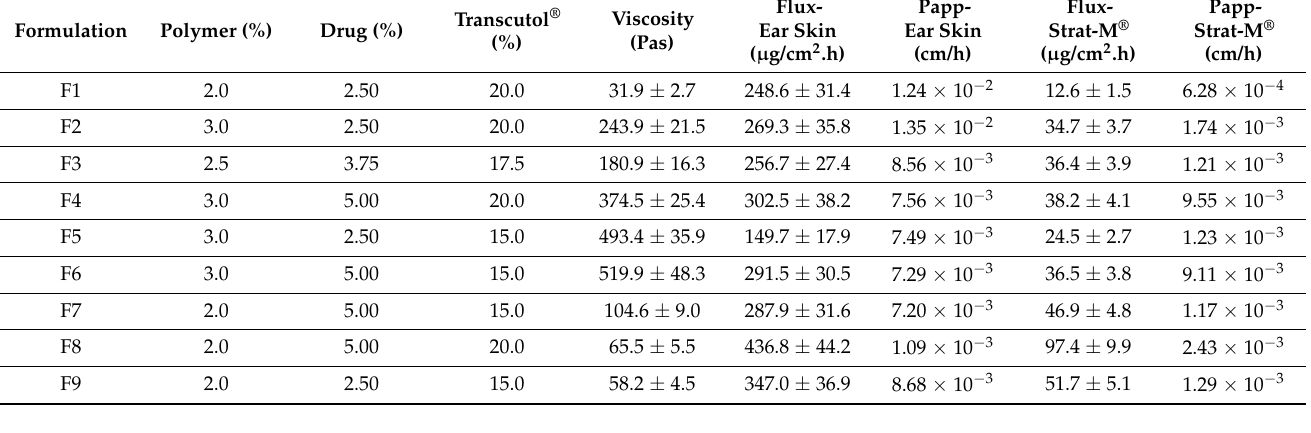
Table 1. Composition of desloratadine hydrogel formulations and their characterizations.